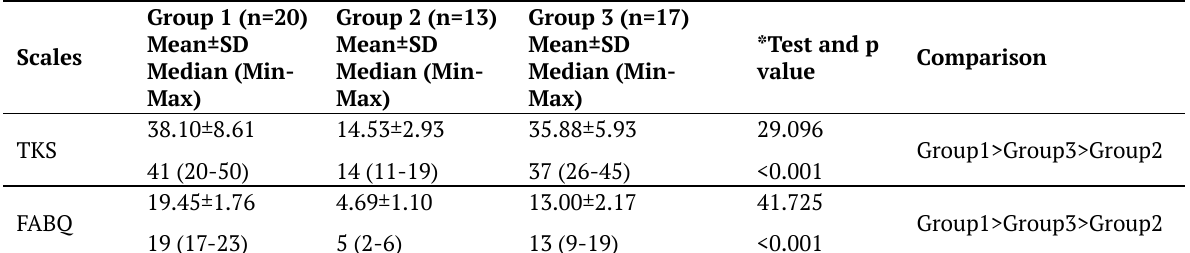
Table 2. Comparison of the groups in terms of kinesiophobia and fear avoidance beliefs scores